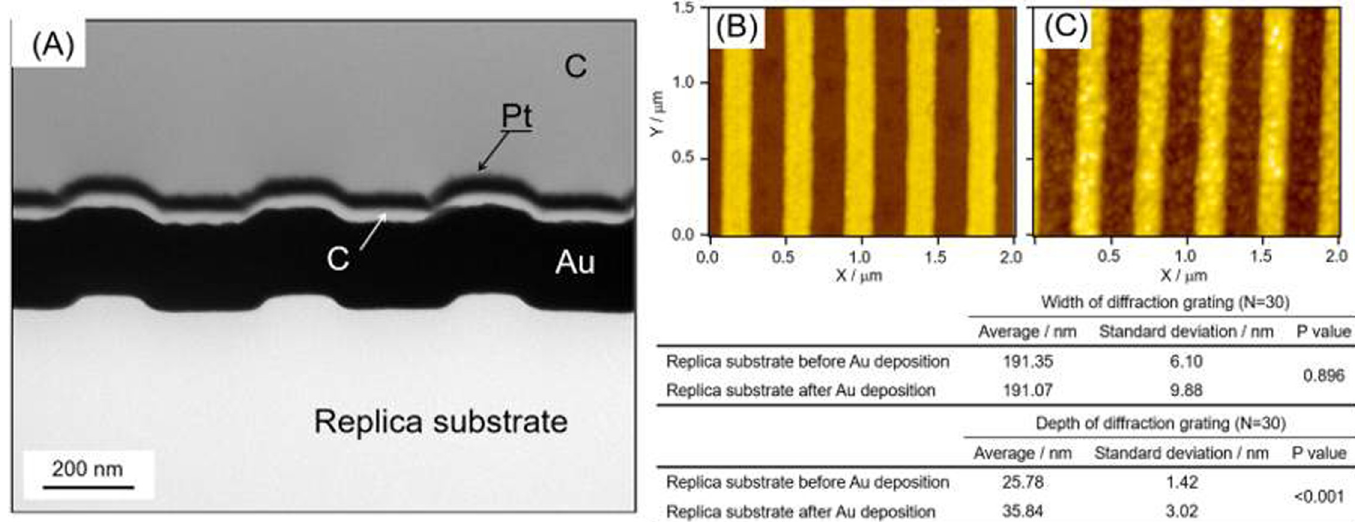
Fig 2. AFM images of diffraction grating nanoimprinting replica substrate. (A) SEM image of a cross-section of the surface of the GC-SPFS sensor chip. This was acquired from a pre-coated GC-SPFS sensor chip of carbon/Pt/carbon for clear observation. The pitch, depth, and duty ratio (ratio of the convex surface of the pitch) of the grating design were 400 nm, 20 nm, and 0.50, respectively.AFM images of diffraction grating nanoimprinting replica substrate before (B) and after (C) Au deposition. Reproducibility evaluation by AFM as shown in the table, indicates that there was no change in the width of the diffraction grating after Au deposition. However, the depth of the diffraction grating and its surface Ra were clearly changed after Au